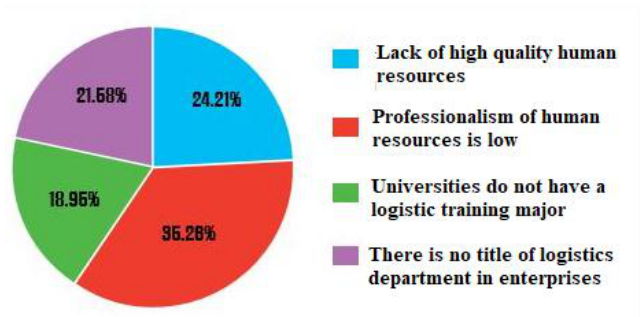
Figure 3: Survey results on human resource constraints of the Vietnam Logistics